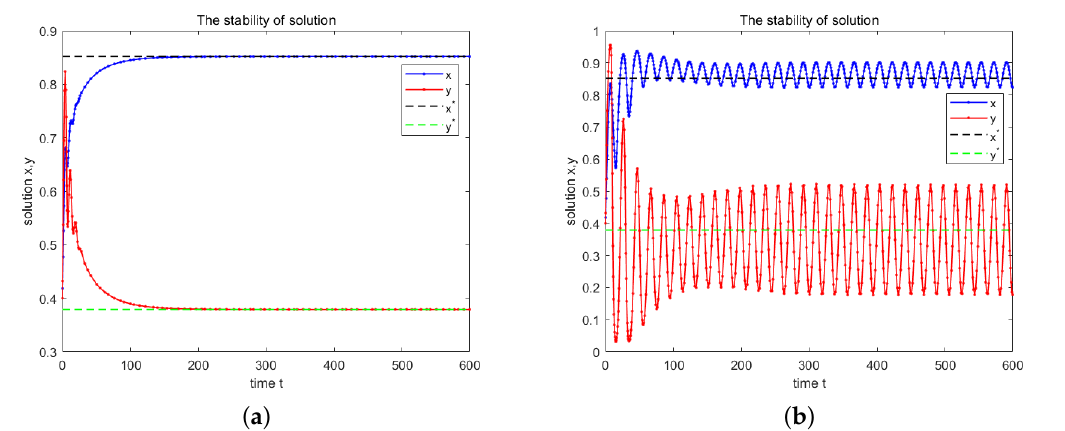
Figure 1. ( a ) The stability of the mixed ESS when τ 1 = 2, τ 2 = 3 time units. ( b ) The instability of the mixed ESS when τ 1 = 6, τ 2 = 7 time units, where p 0 = 0.4, p 1 = 0.5, p 2 = 0.1 and q 0 = 0.3, q 1 = 0.6, q 2 =